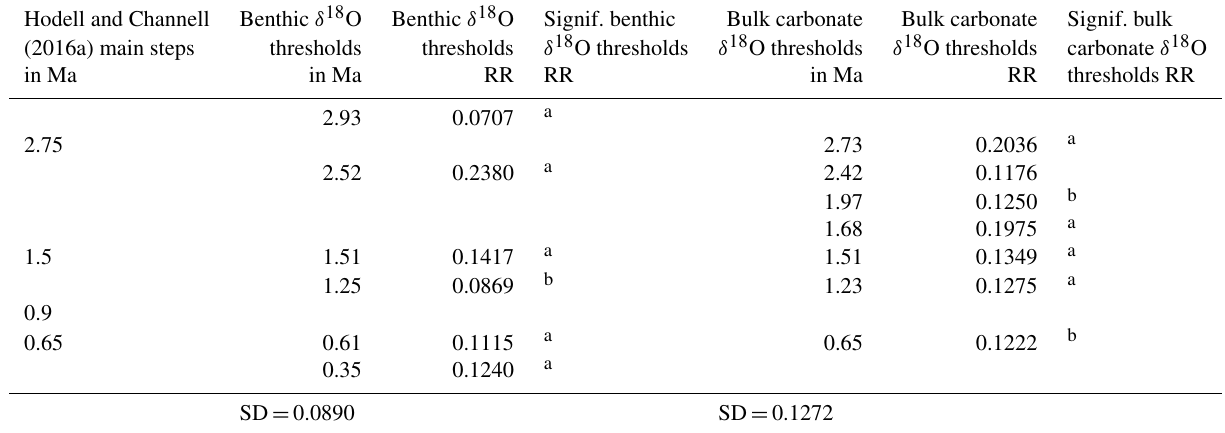
Table 2. Comparison of the main steps detected by Hodell and Channell (2016a) from the U1308 marine record with those deduced from the recurrence plot of the benthic δ 18 O and bulk carbonate δ 18 O data of the same record. RR prominence significance is defined the same way as in Table 1. Hodell and Channell Benthic δ 18 O Benthic δ 18 O Signif. benthic Bulk carbonate Bulk carbonate Signif. bulk thresholds thresholds δ 18 O thresholds δ 18 O thresholds δ 18 O thresholds carbonate δ 18 O in Ma in Ma RR RR in Ma RR thresholds